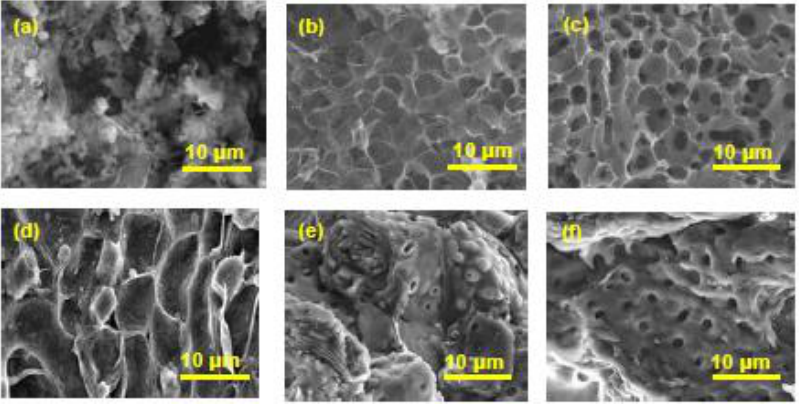
Figure 2. SEM images: ( a ) rapeseed cake biochar (RSC); ( b ) rapeseed cake biochar activated with KOH (RSC K ); ( c ) rapeseed cake biochar activated with H 2 SO 4 (RSC S ); ( d ) walnut shell biochar (WSC); ( e ) walnut shell biochar activated with KOH (WSC K ); ( f ) walnut shell biochar activated with H 2 SO 4 (WSC S ).